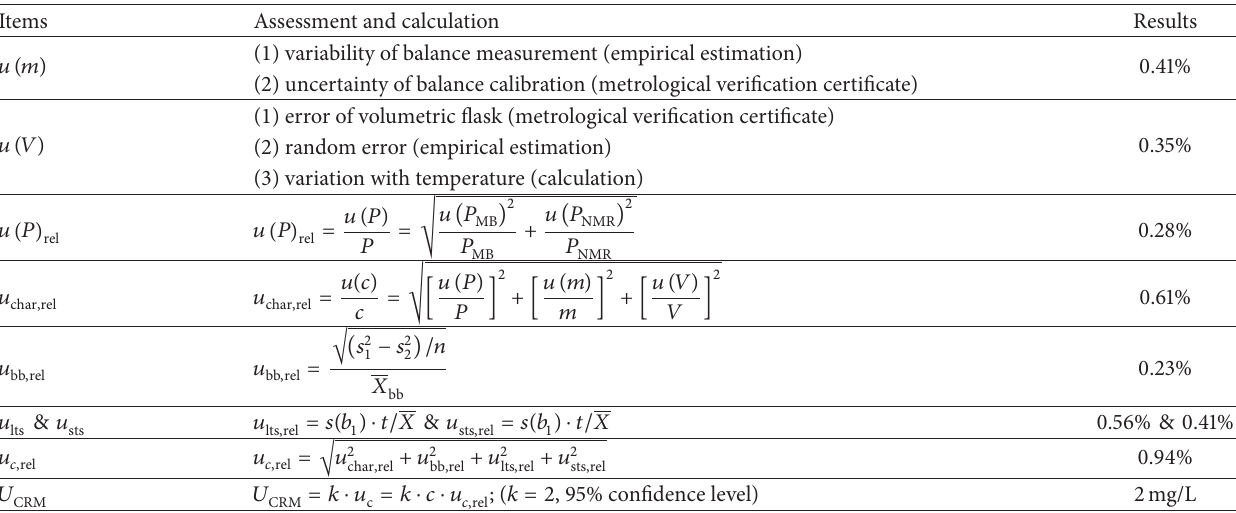
Table 7: Results of